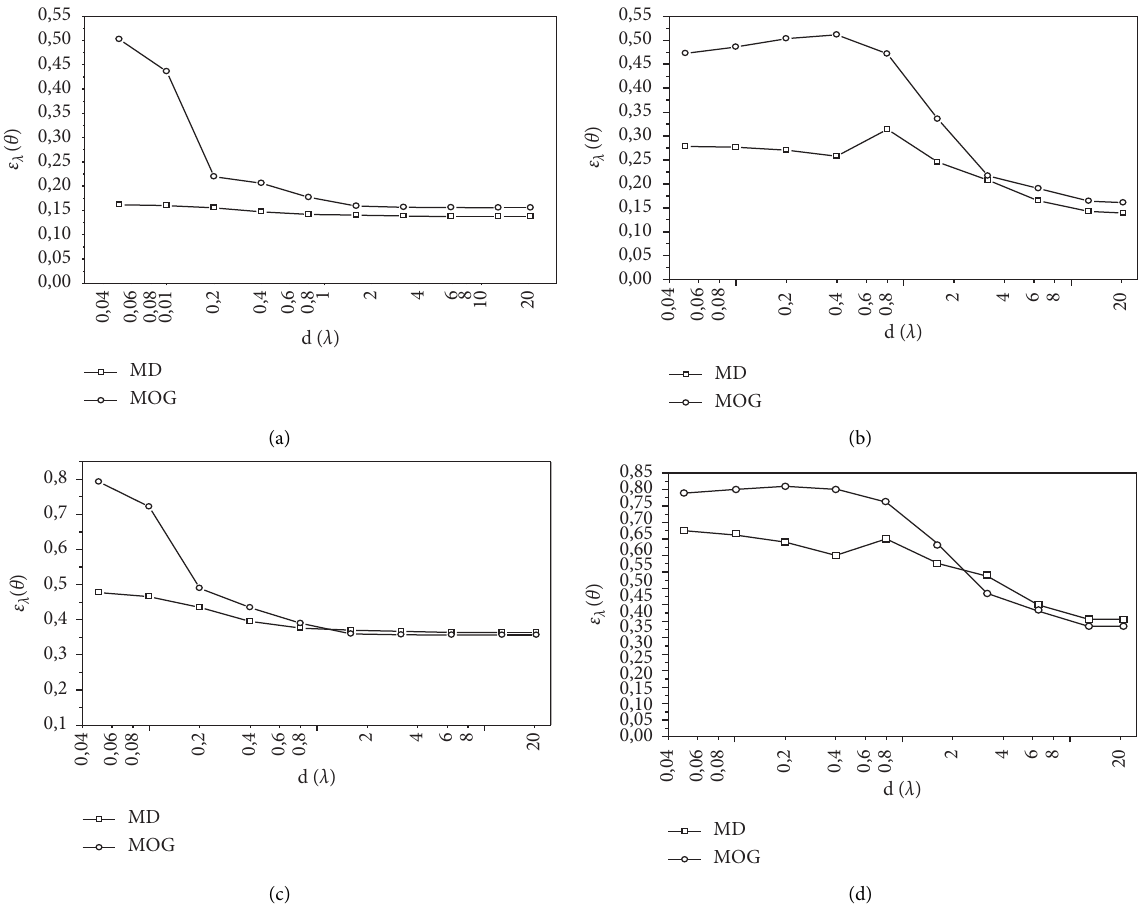
Figure 2: Emissivity as a function of d / λ parameters: (a) Or, h � 0 . 1 λ and θ � 50 ° ; (b) gold: h � 1 λ and θ � 50 ° ; (c) tungsten: h � 0 . 1 λ and θ � 50 ° ; (d) tungsten: h � 1 λ and θ � 50 ° .